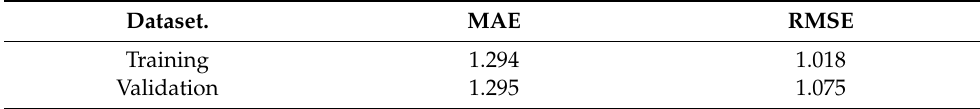
Table 1. MAE and RMSE of point estimation for surface concentration (unit: µ g/m 3 ).